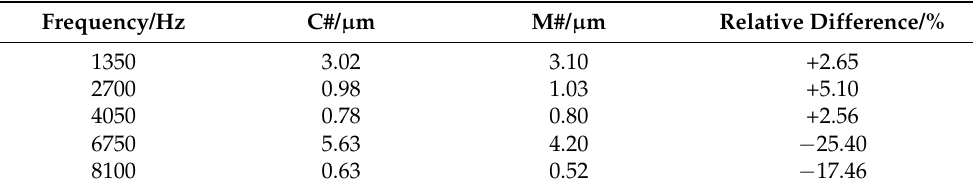
Table 3. Maximum amplitude of R1 rotor blade.